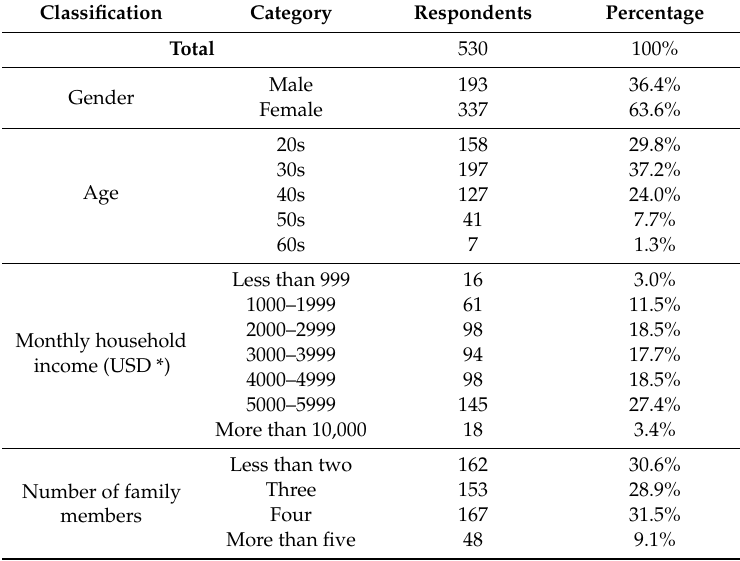
Table 4. Residence characteristics of the